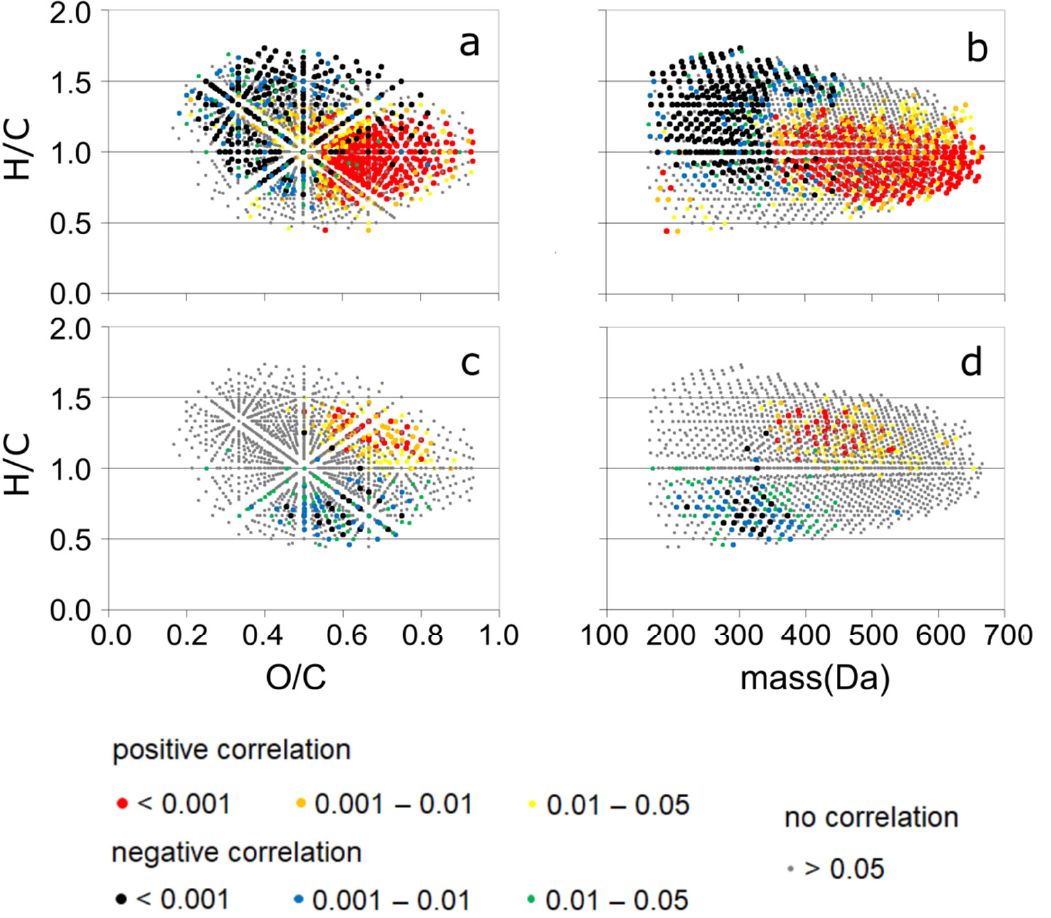
Figure 8. Spearman’s rank correlations between relative intensities of molecular formulas (MFs) as detected by FTICR MS and DOC ( a , b ) and SUVA ( c , d ) of all CHO-MF found in all 48 samples. The legend shows positive and negative correlations and MFs with no correlations ( p > 0.05) and different p -values ( p < 0.001, 0.001 < p < 0.01, and 0.01 < p < 0.05).